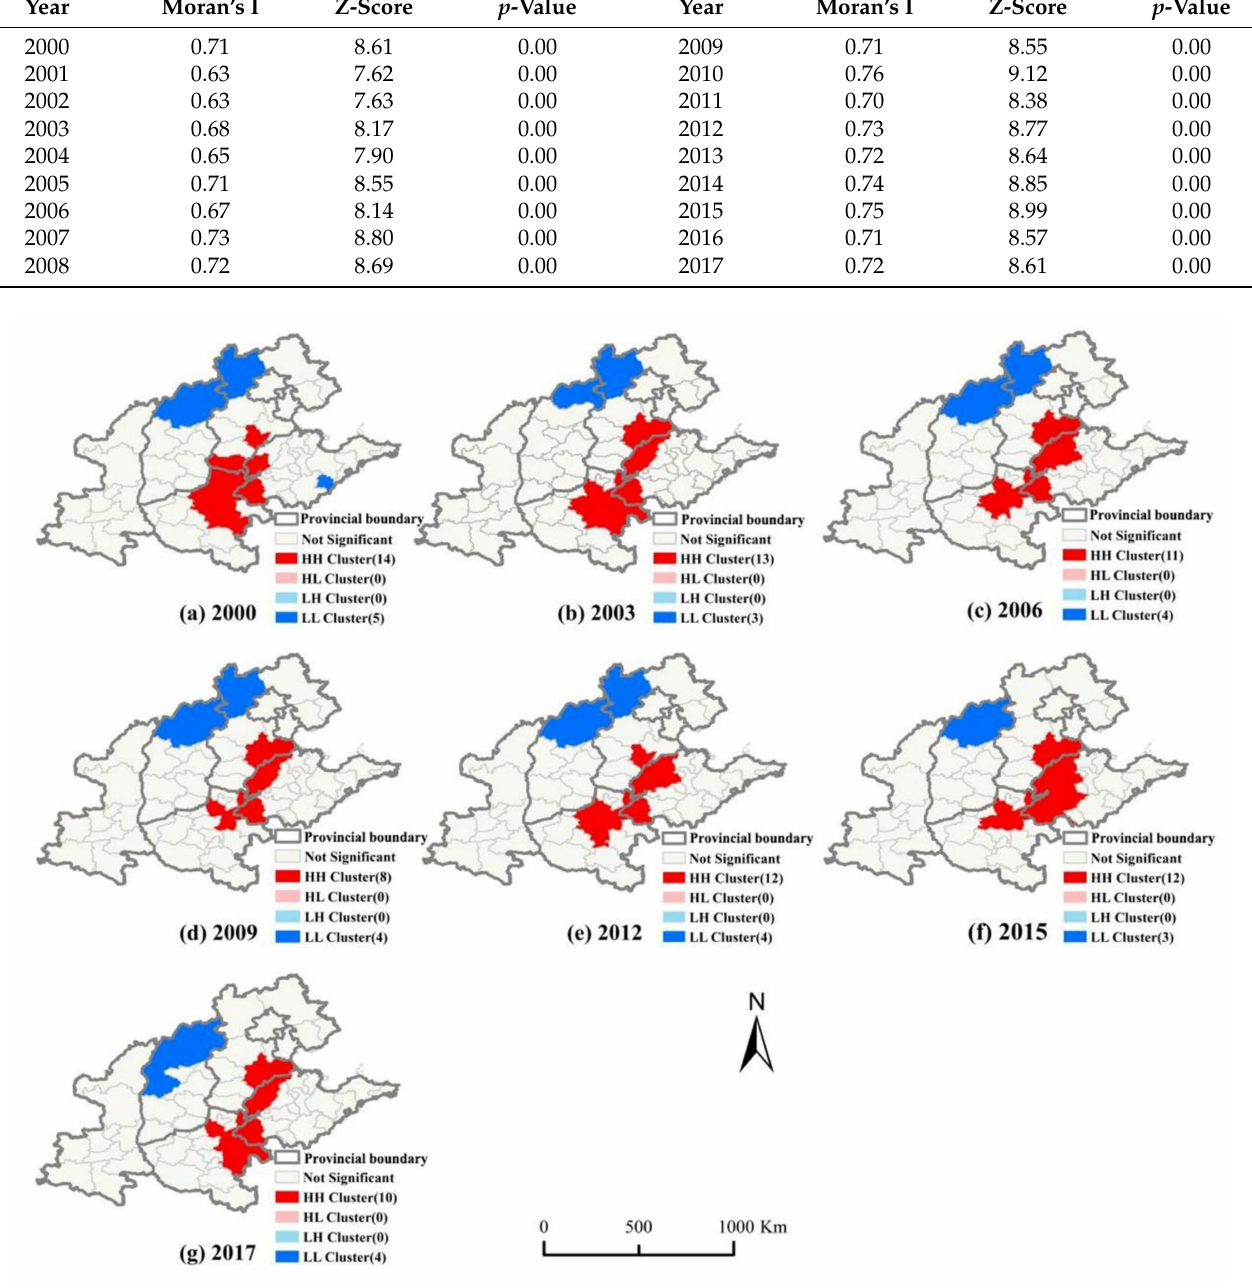
Figure 7. Local spatial autocorrelation